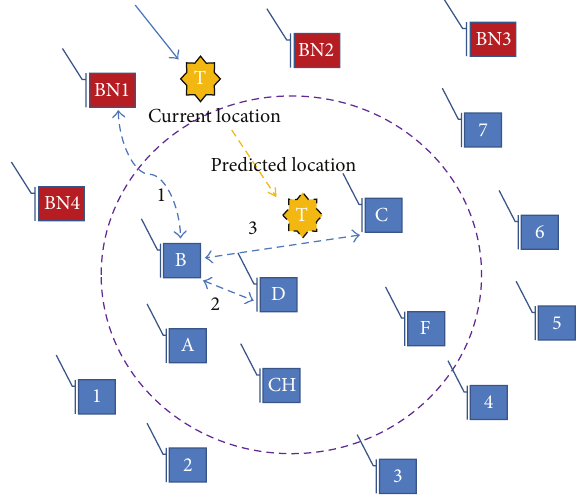
Figure 2: Tracking with event driven clustered